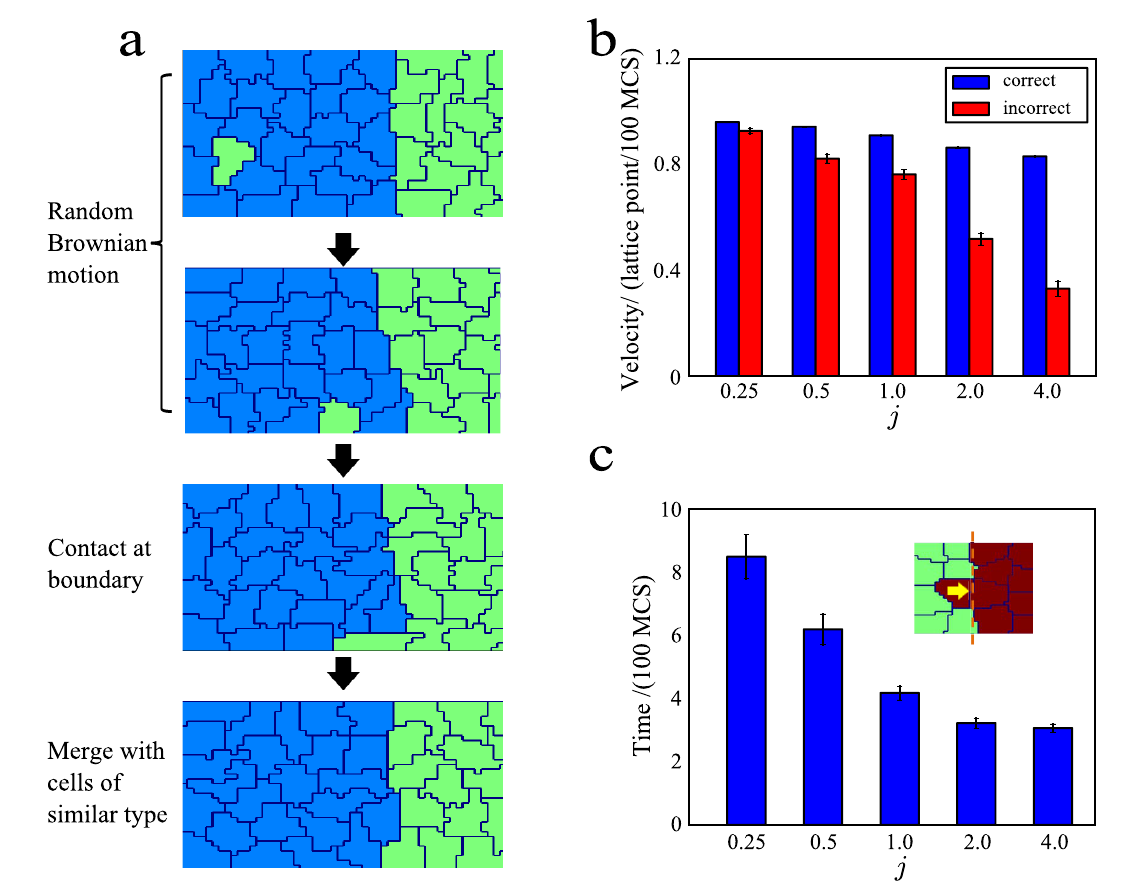
Figure 3. Speed of misspecified cells decreases with magnitude of differential adhesion, j . ( a ) The cell grid as time progresses (top to bottom). ( b ) Bar graphs showing the speeds of correctly specified (blue) and incorrectly specified cells (red) for different values of j . ( c ) Bar graph of the merging time for different values of j . (Inset) Cell grid showing the initial configuration of the cells. The average time taken for the centroid of the misspecified to cross the boundary (dotted line in orange) is measured for 100 runs. Error bars show the standard errors.